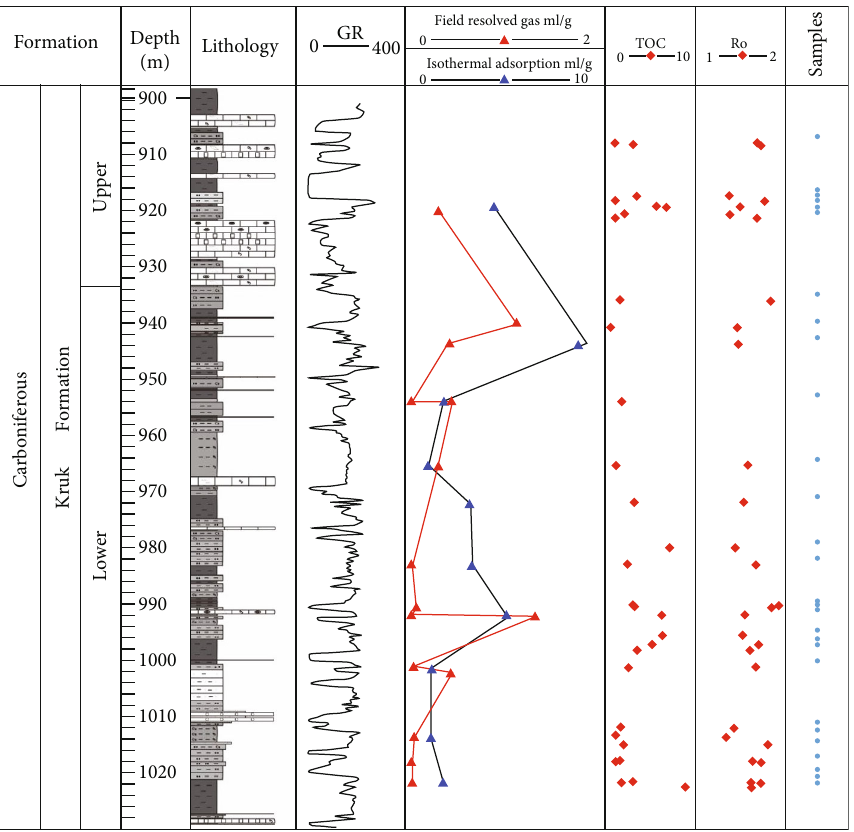
Figure 3: Comprehensive column of the core section of the Well Chai-Shale